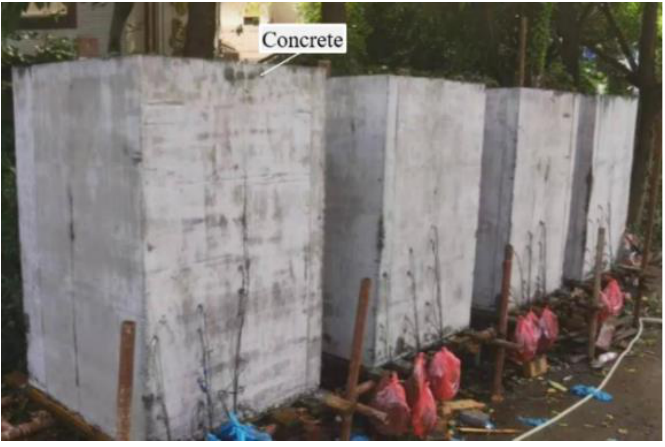
Figure 6. Manufactured members.